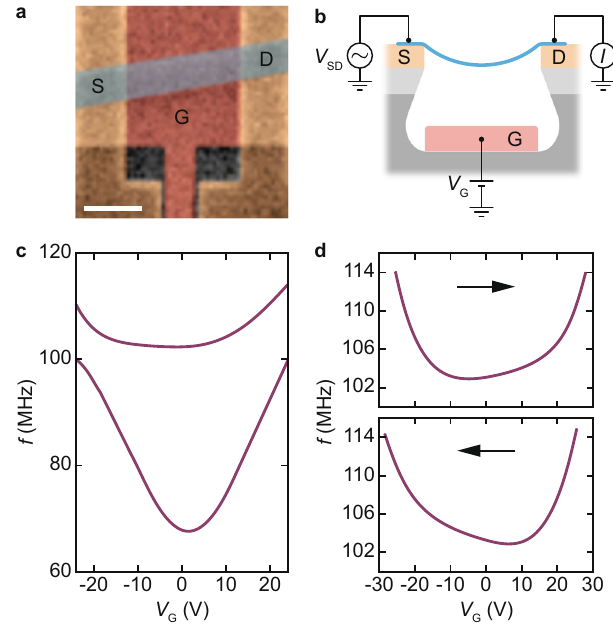
Fig. 1 | Unconventional resonant frequency tuning spectra in few-layer gra- phene (FLG) resonators. a Colorized scanning electron microscope (SEM) image of the device. FLG (blue shaded stripe) is connected to source (S) and drain (D) electrodes and is suspended over a gate electrode (G). Scale bar: 1 micrometer. (cid:4) b Schematic of the device. A frequency-modulated voltage V SD = V 0 cos 2 π f d t + Þ sin2 π f t (cid:3) is applied between S and D, where f ð f Δ = f m m d is the drive frequency, : 37 kHz is the modulation frequency, and f Δ = f ≈ 75 (see Methods). A dc f m =1 m voltage V G isappliedtoG.Adraincurrent I atfrequency f m ismeasured. c Resonant frequency f ofthe fi rstandsecondvibrationalmodesoftheresonatorshownin a as a function of V G . d f as a function of increasing (upper panel) and decreasing V G (lower panel). Arrows indicate the stepping direction of V G . The drive power is − 39dBm in c , d